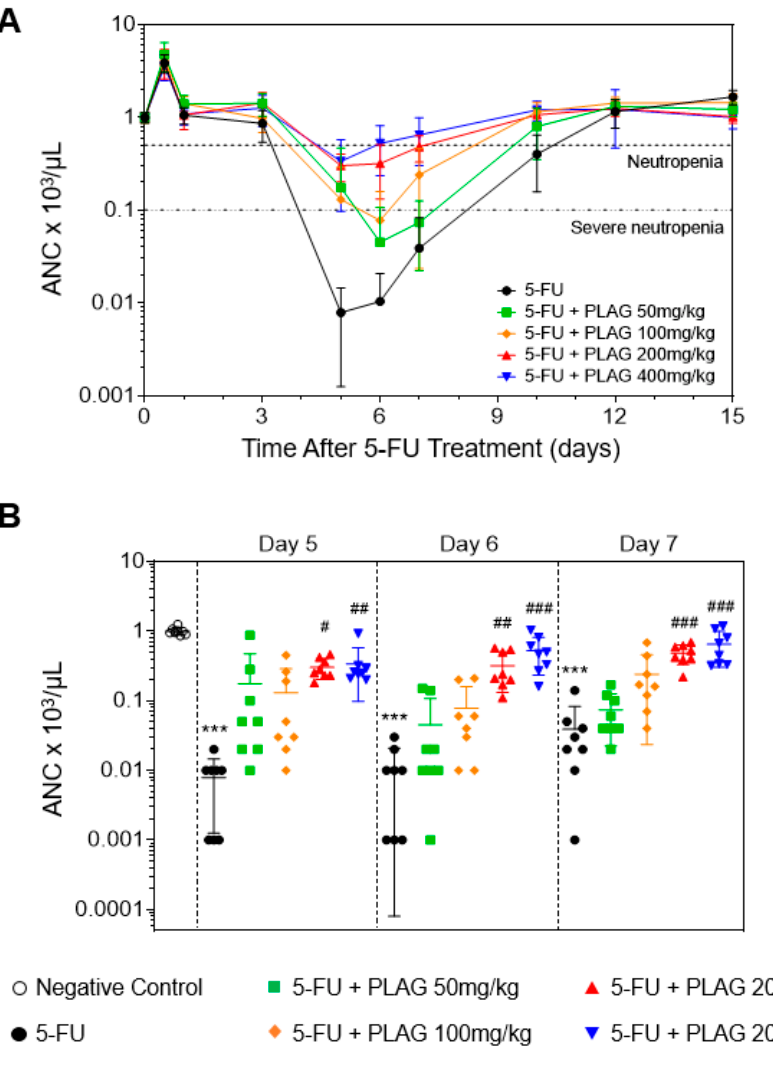
Figure 1. 1-palmitoyl-2-linoleoyl-3-acetyl-rac-glycerol (PLAG) mitigates 5-Fluorouracil (5-FU)-induced neutropenia. Mice ( n = 8 males per group) were intraperitoneally injected to 100 mg / kg of 5-FU immediately followed by oral administration of 50, 100, 200, and 400mg / kg of PLAG and continuing daily to day 15. ( A ) Effect of PLAG administration on the kinetics of the absolute neutrophil counts (ANCs) after 5-FU injection for 15 days. ( B ) Individual ANC data are presented as dots on days 5, 6, and 7. * indicates negative control vs. 5-FU and # indicates 5-FU vs. 5-FU + PLAG-treated groups. */# p < 0.05, **/## p < 0.01, ***/### p < 0.001. The complete blood counts (CBCs) data are representative of five independent experiments with eight mice per group.